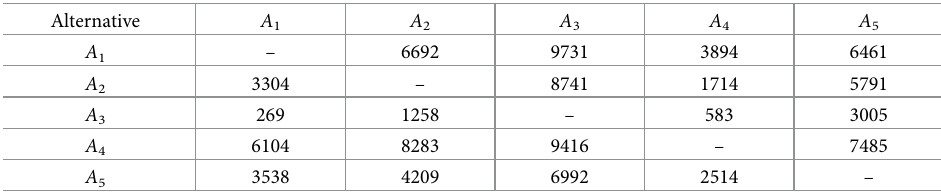
Table 3. Alternatives’ evaluation with respect to Definition 2.